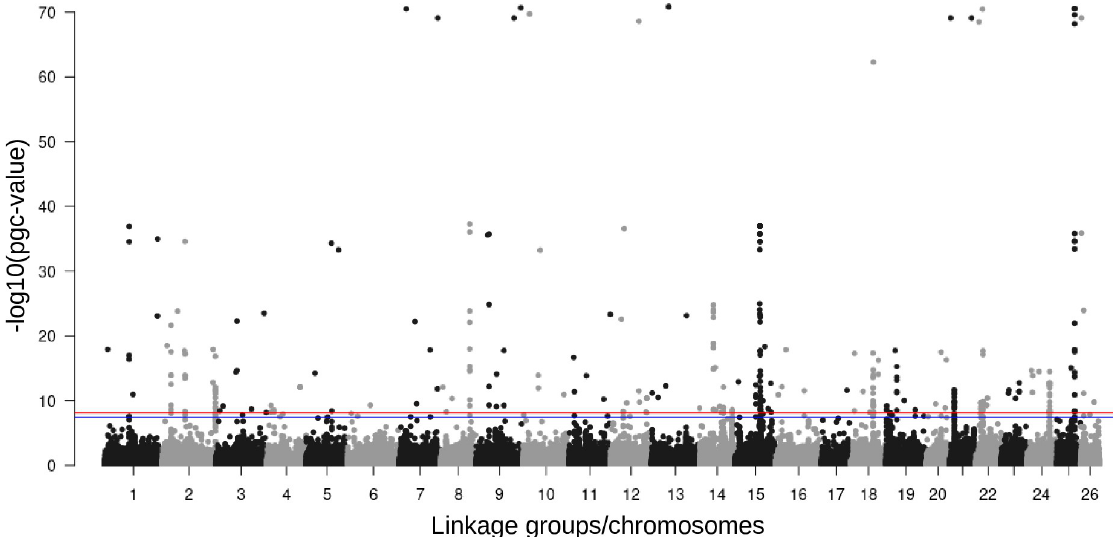
Fig 5. Genome-wide divergence between odd and even-year pink salmon lineages. A Manhattan plot of eigenGWAS results, with chromosome positions on the x-axis and p-values (corrected for genetic drift using the genomic inflation factor) on the y-axis to identify regions of the genome potentially under selection. The red horizontal line represents a Bonferroni correction at α = 0.01 and the blue line at α = 0.05. All positions are from the odd-year genome assembly. https://doi.org/10.1371/journal.pone.0255752.g005 From previous research [117, 118], a pseudo growth hormone 2 gene was shown to be tightly linked to sex-determination in pink salmon. Four tandem duplicates of this gene (NCBI: DQ460711.1) were identified on the same contig in the even-year genome assembly,